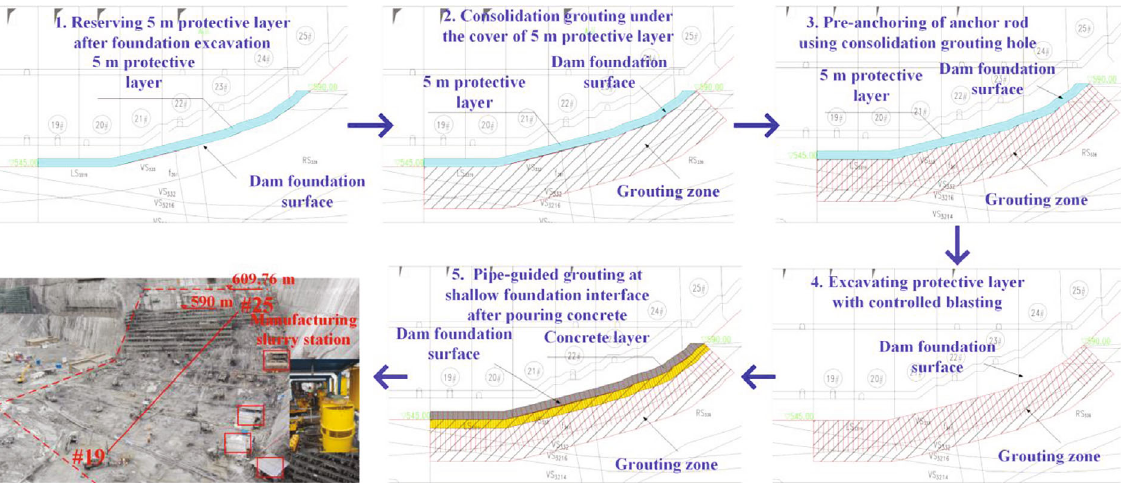
Figure 18: Overall construction process diagram of consolidation grouting at the right bank dam